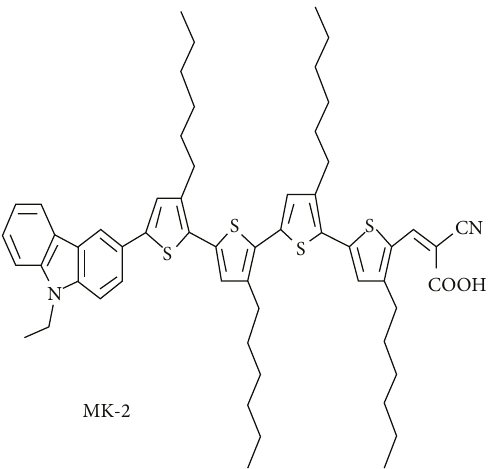
Figure 1: Molecular structure of MK-2 dye.